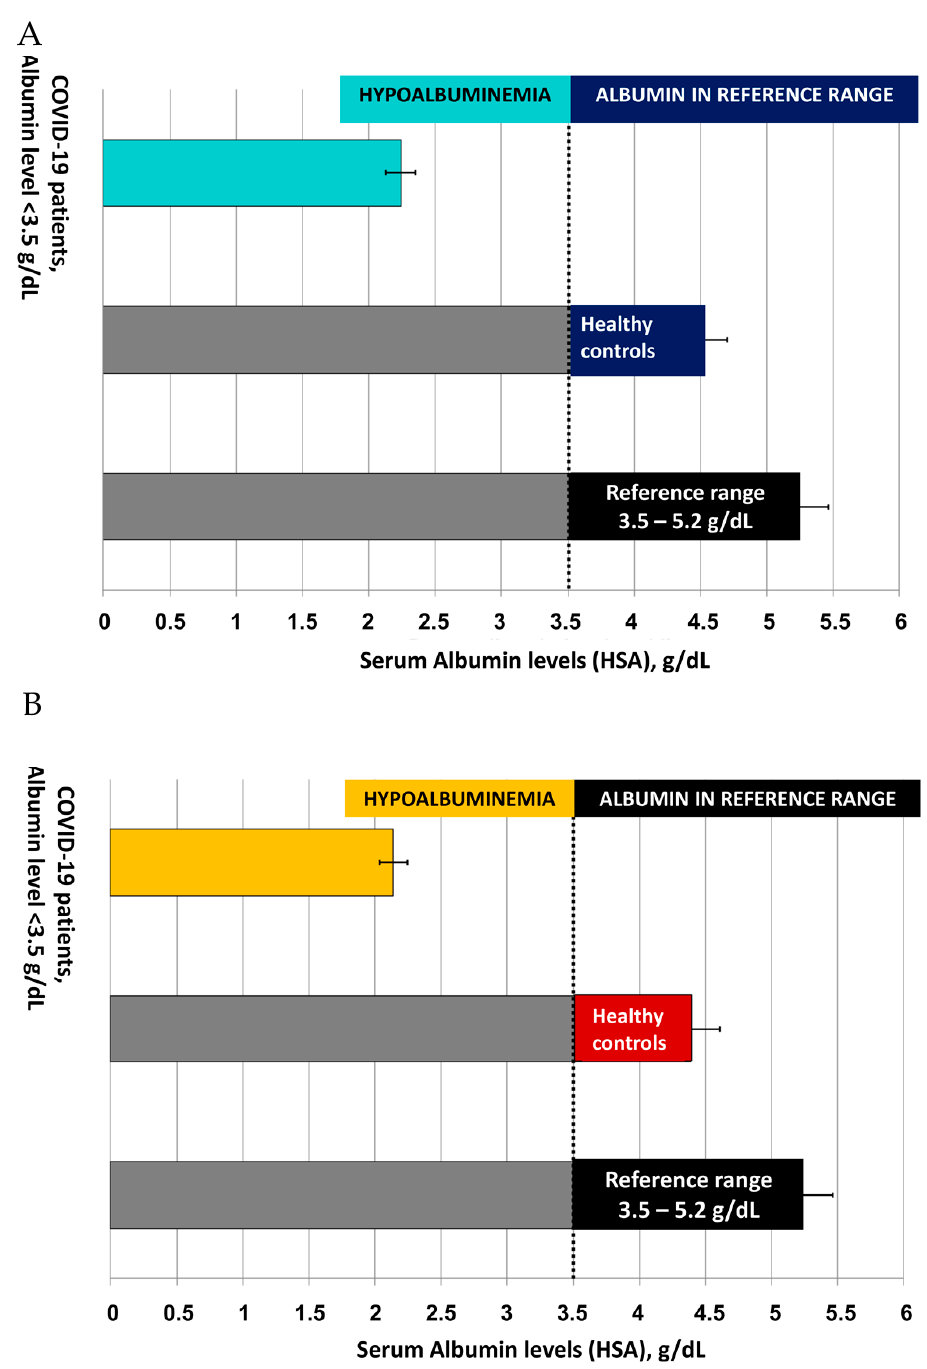
Figure 1. Graphical representation of serum albumin levels in patients with COVID-19 by sex. HSA reference values from 3.5 to 5.2 g/dL (in black) for ( A , B ); ( A ) (male): mean HSA of three clinically healthy volunteers (in dark blue); serum albumin level of patients with COVID-19 (in light blue); ( B ) (female): mean HSA of three clinically healthy volunteers (in dark red); serum albumin level of patients with COVID-19 (in yellow). Significant differences in serum albumin values were observed in patients with COVID-19 compared to controls. Low protein levels in Group 2 suggest a critical deterioration in patients [22]. The results were presented as mean ± S.E. Analysis of the data showed that at an average albumin value of 2.19 g/dL ± 0.05 g/dL, the mortality rate was 100%.